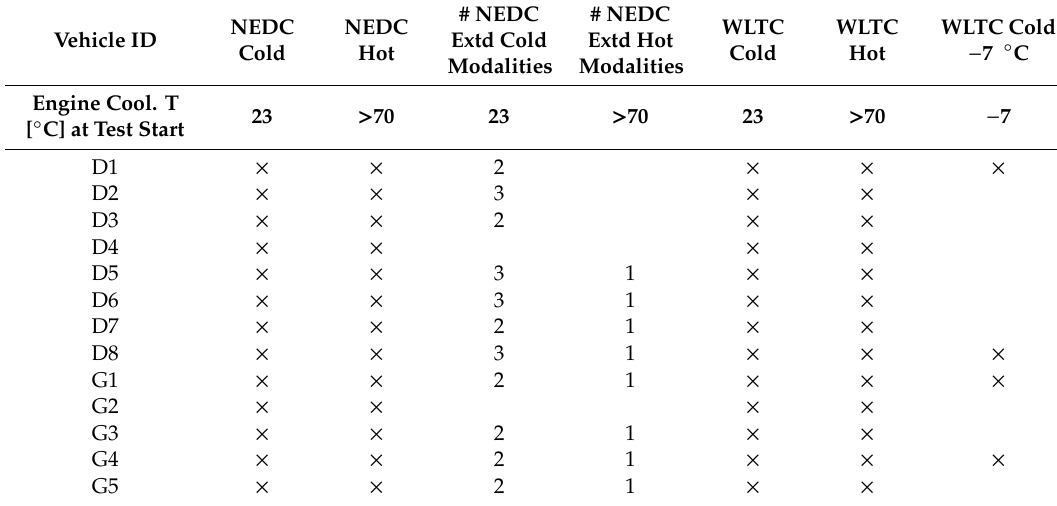
WLTC WLTC WLTC Cold − 7 ◦ C Cold Hot